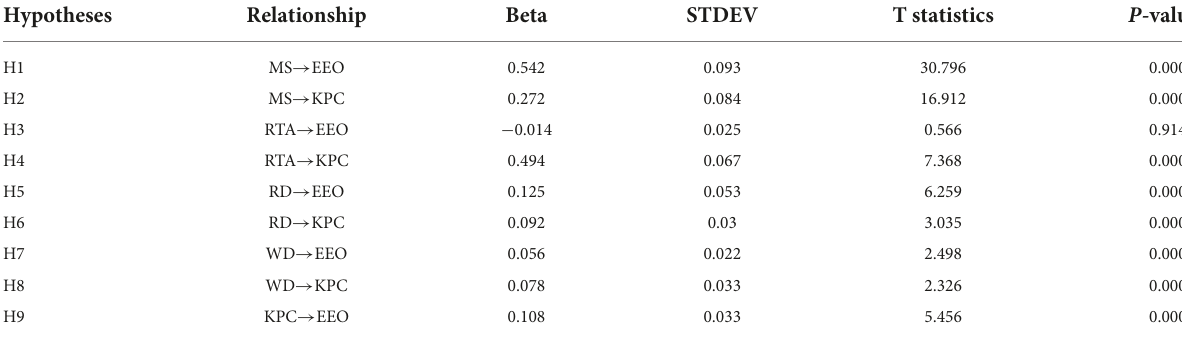
TABLE 5 Structural model assessment (direct effect results and decision).